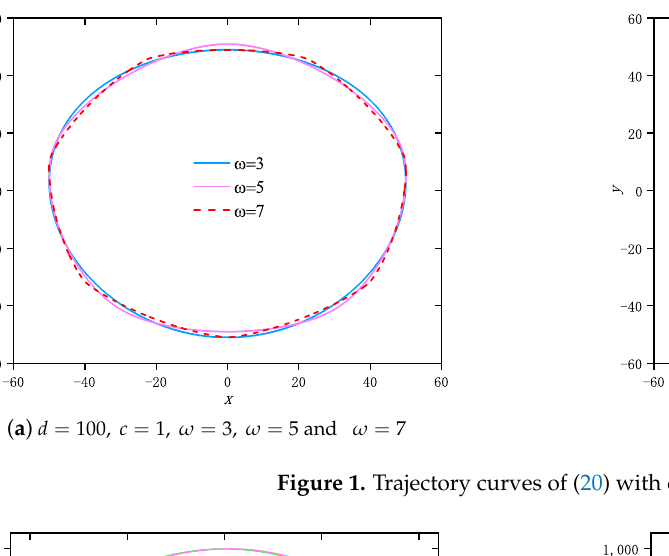
Original curve of constant width The curve after the first derivative